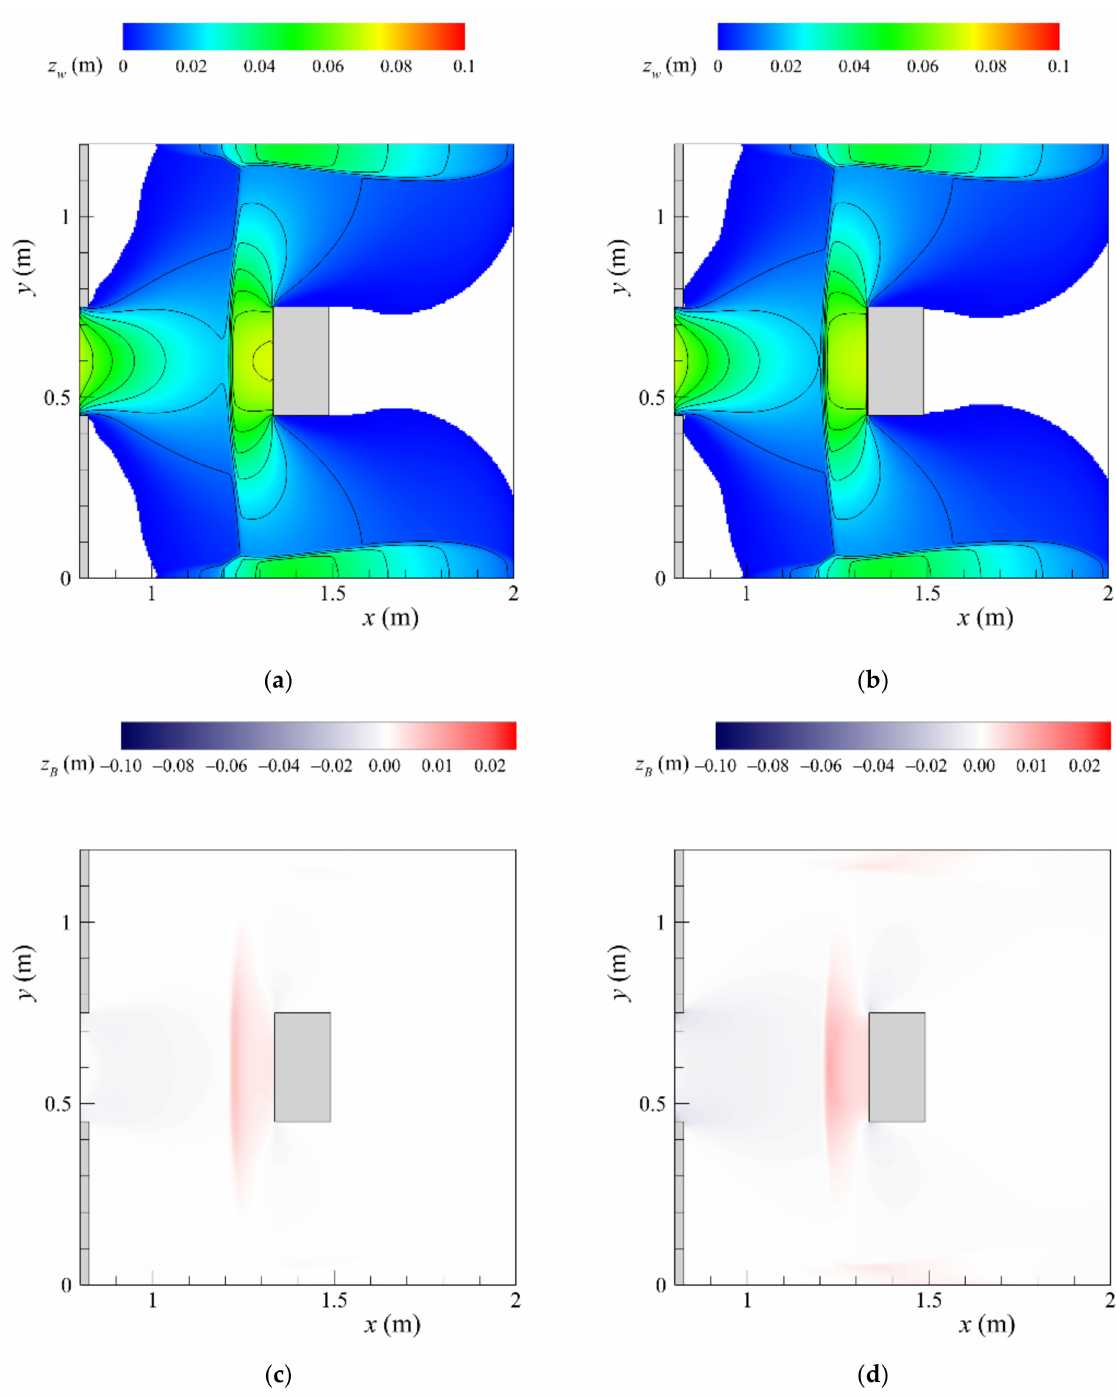
Figure 3. Results for sand particle d = 5 × 10 − 3 m at t = 1.5 s: ( a ) free-surface elevation predicted by the SVEM; ( b ) free-surface elevation predicted by the TPM; ( c ) bottom elevation predicted by the SVEM; ( d ) bottom elevation predicted by the